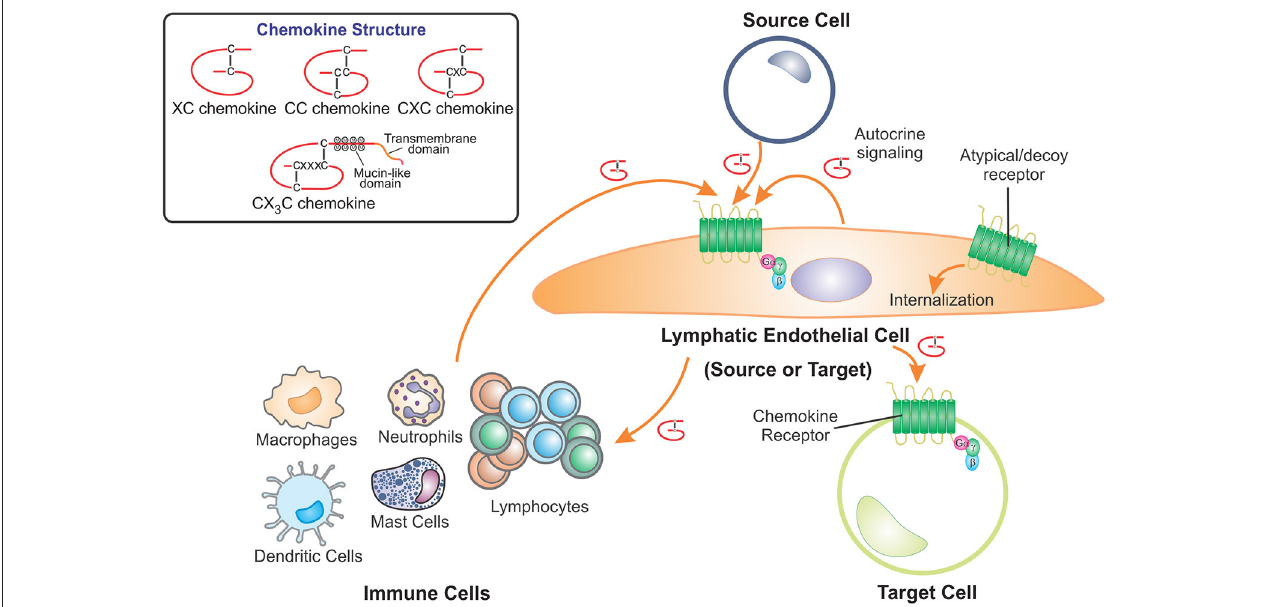
FIGURE 1 | LECs contribute to the role of chemokines by acting as either the source or target cell. Chemokines are a structurally related family of cytokines that direct cell movement and are classified as XC, CC, CXC, or CX 3 C chemokines depending on the positions of conserved cysteine residues which form disulfide bridges. Lymphatic endothelial cells (LECs) receive chemokine signals, using cell surface G protein-coupled receptors, from source cells which include cells of the immune system, other LECs, fibroblasts and pathological cells types such as cancer cells. LECs also act as the source of chemokines, secreting these proteins to act on chemokine receptors present on other target cells. Furthermore, LECs can regulate chemokine availability by scavenging and internalizing secreted chemokines via atypical or decoy chemokine